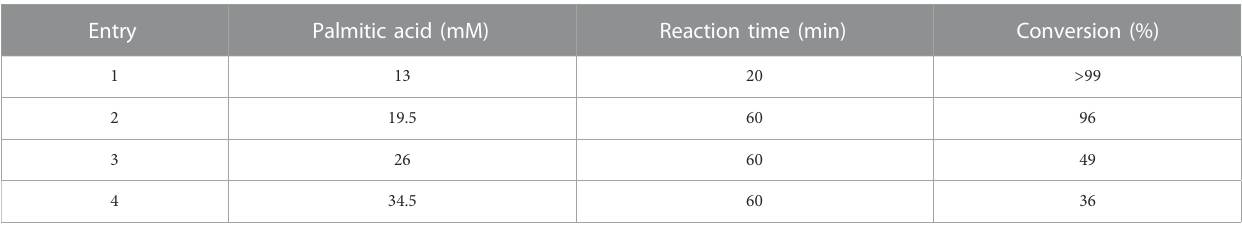
TABLE 2 In fl uence of higher palmitic acid concentration on the performance of the Cv FAP-catalyzed photodecarboxylation under solar light irradiation. Entry Palmitic acid (mM)